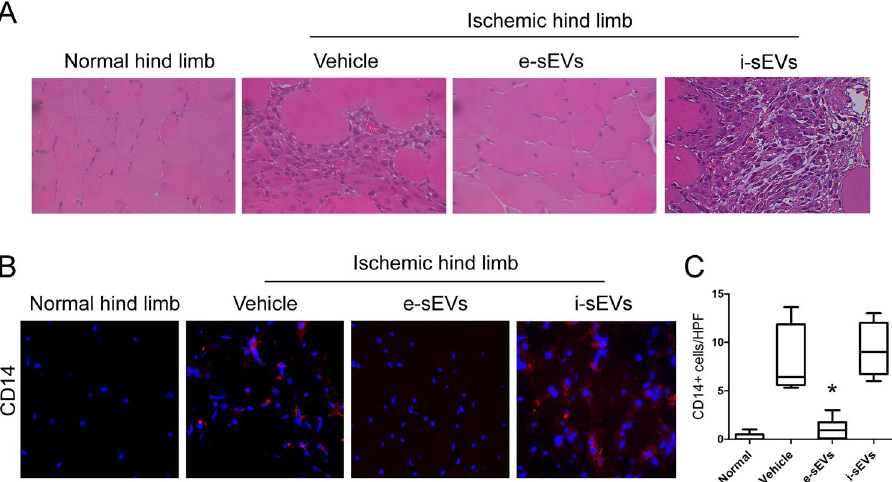
Figure 4. Inflammatory infiltrate in ischemic hind limb. ( A ) Representative hematoxylin-eosin images of gastrocnemius muscles of non-ischemic (Normal hind limb) and ischemic hind limbs of Vehicle, e-sEVs and i-sEVs treated animals (Original Magnification: × 400; scale bar: 25 µ m), showing mononuclear and polymorphonuclear cells. ( B ) Representative immunofluorescence images of gastrocnemius muscles, stained with an anti CD14 antibody (Original Magnification: × 400; scale bar: 25 µ m). ( C ) Quantitative analysis of muscle damage areas in hematoxylin-eosin stained gastrocnemius muscles of the normal and ischemic hind limbs at day 7 after surgery. e-sEVs significantly reduce the number of inflammatory cells compared to the control (vehicle). Data are expressed as mean ± SEM; * p < 0.05, e-sEVs vs Vehicle, (One-Way ANOVA - Newman-Keuls Multiple Comparison Test) (n =